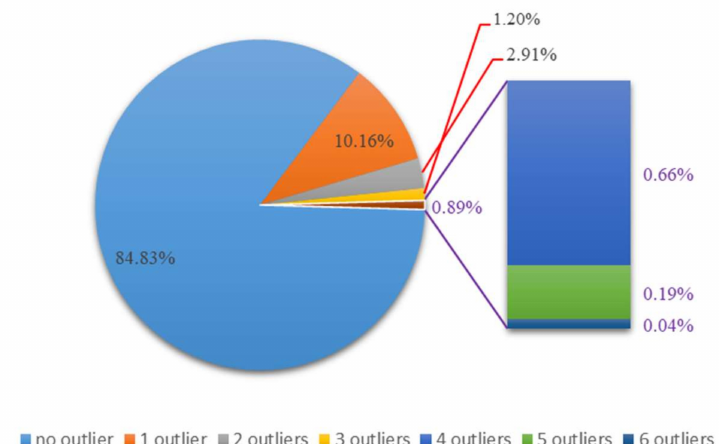
Figure 13. Percentage of different threshold overshoot numbers in training